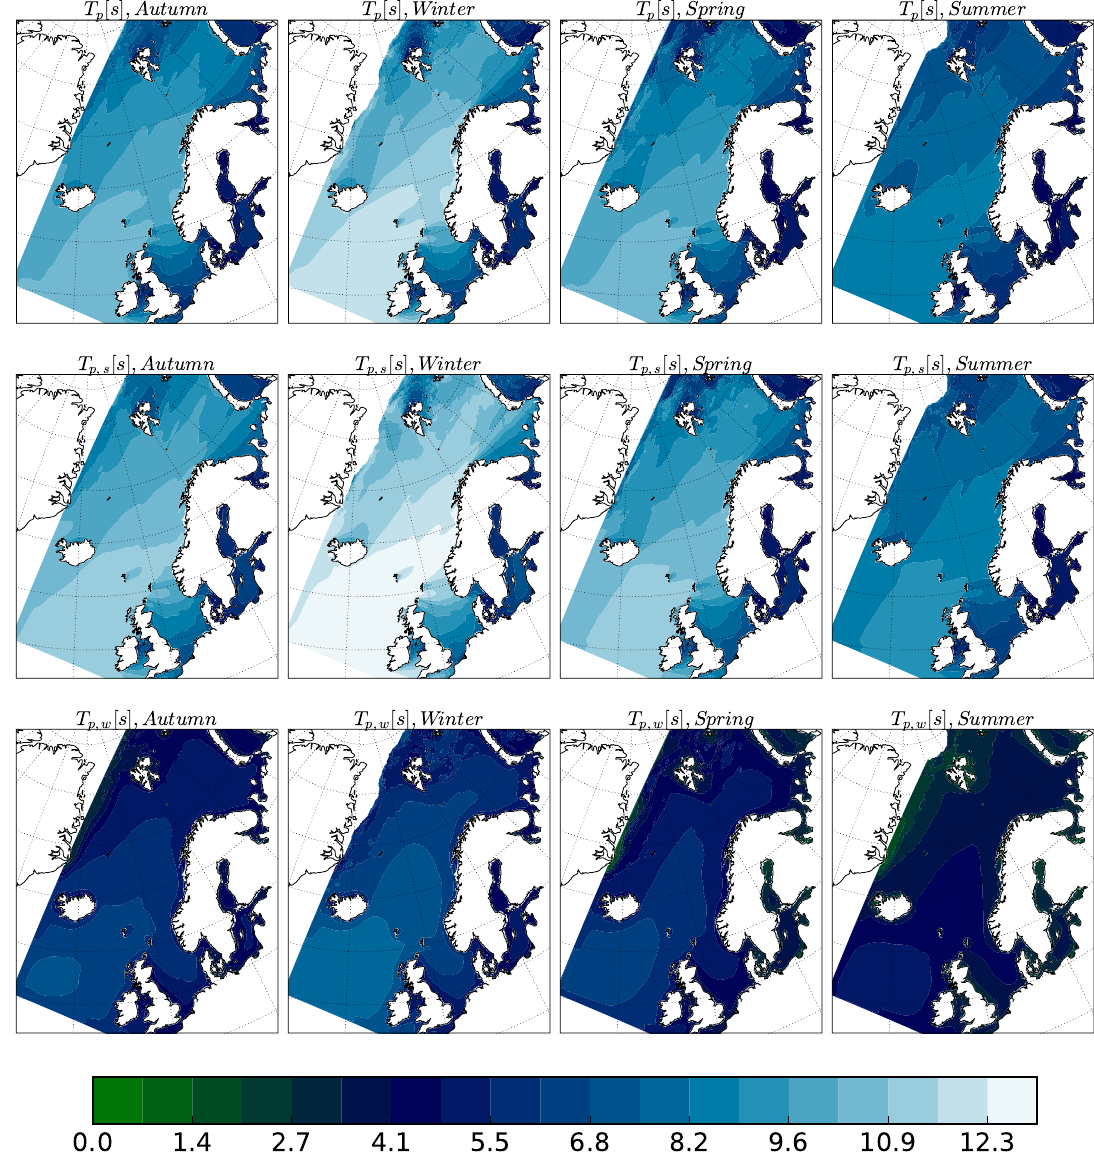
Figure 4. The average seasonal (autumn, winter, spring, and summer) T p , T p , s , and T p , w for the NORA10 domain for the period